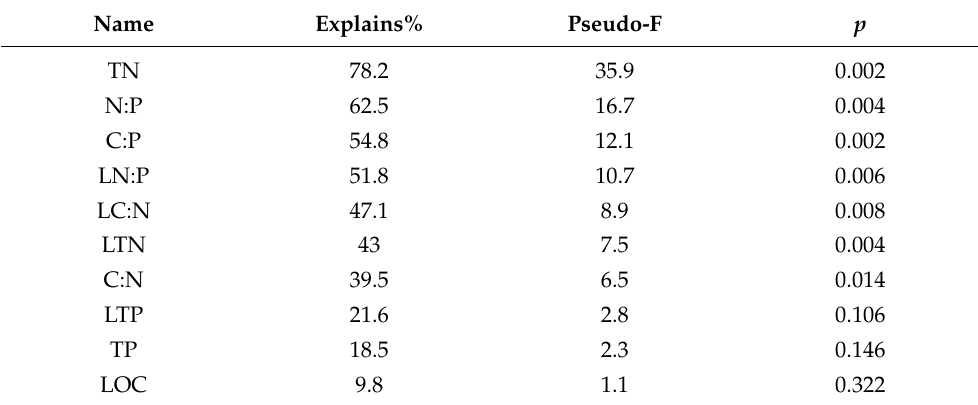
Table 3. The importance ranking and significance test results of the nutrient and ecological stoichio- metric